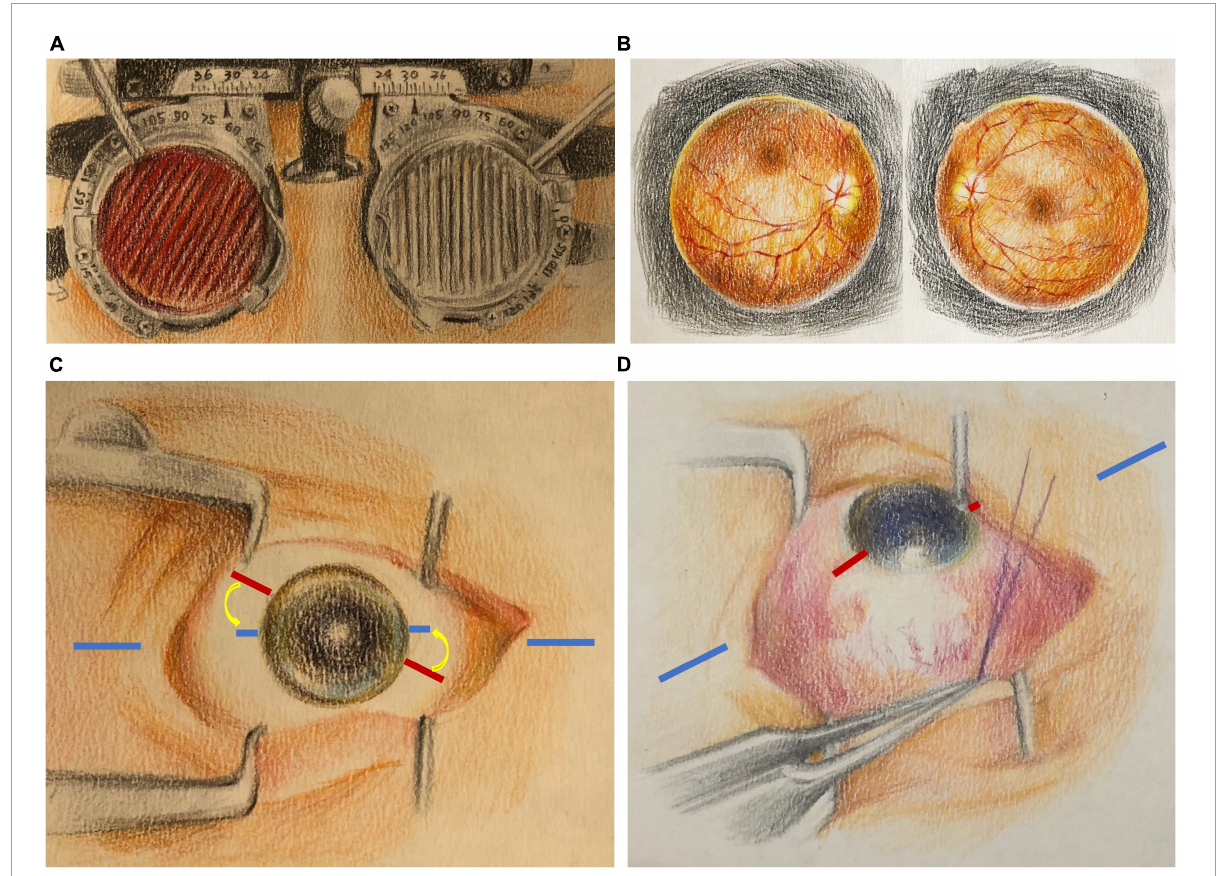
FIGURE1 Pre- and intraoperative preparation for the simple torsion markings technique. In this instance, a significant incyclotorsion was measured subjectively with the double Maddox rod test (A) and confirmed objectively with the color fundus photography (B) . (C) The amount of cyclodeviation to be corrected was determined from the preoperative exams (A,B) and marked on the ocular surface before the surgery (red lines, indicating the surgical torsion markings) clockwise above the ocular and external horizontal markings (blue lines). For example, in a patient with a 15 ◦ incyclotorsion in the right eye, a surgical torsion marking should be marked 15 ◦ clockwise above the original ocular horizontal markings. In contrast, for a patient with excyclotorsion in the right eye, counter-clockwise surgical torsion markings should be placed below the original ocular horizontal markings, and vice versa with the left eye. (D) The surgical goal was to realign the surgical torsion markings (red lines) until parallel to the external horizontal markings (blue lines) using any adjustable surgical approach, which eventually achieved an excyclotorted